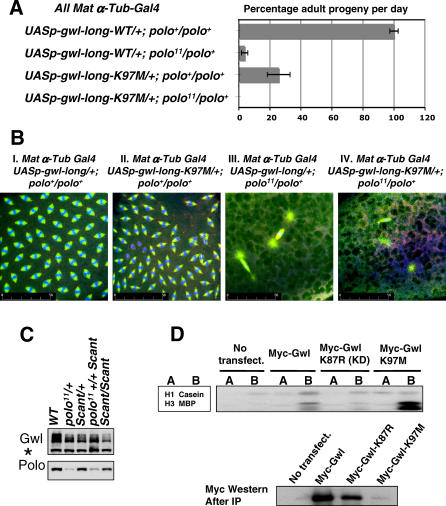
Gwl-K97M Is Hyperactive(A) Effects of overexpressing gwl-long-wt or gwl-long-K97M (Scant) on female fertility. Mat α-Tub-Gal4 and the UASp-gwl transgenes were present in only one copy on the same chromosome in all flies tested. Single females of the indicated genotypes with 3 WT (Oregon R) males laid eggs for 3 consecutive d. Numbers are averages of hatched adult progeny (± standard error of the mean) per day for 12 females of each genotype (three females of each of four independent transgenic lines per genotype = 36 samples). The 100% reference comes from the observation of 100% egg hatch and no larval or pupal lethality.(B) Effect of overexpressing gwl-long-wt or -K97M (Scant) on embryonic mitosis. Embryos were laid by mothers of the indicated genotypes and treated as in Figure 2A. Scale bars are in μm.(C) Endogenous Scant protein is not more abundant than Gwl-wt in embryos. Western blots for Gwl and Polo from embryos from mothers of the indicated genotypes. *, cross-reactive band that serves as a loading control.(D) Gwl-K97M is hyperactive in vitro with altered specificity. Myc-tagged forms of Gwl-wt, K87R (kinase dead), and K97M (Scant) were expressed in Dmel stable cell lines. Myc immunoprecipitations were carried out and the kinase activity on Histones H1, H3, Casein, and Myelin Basic Protein was assayed on beads. Note that the Gwl-K97M was always expressed at lower levels in stable cell lines, suggesting toxicity for this protein.